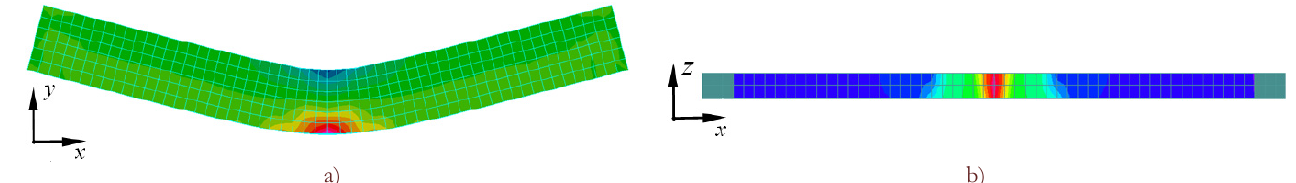
Figure 7: Collapse mechanism of the specimen S6-PRE3: a) contour plot of the strain rate components   c in the deformed configuration of the beam; b) contour plot of the strain rates